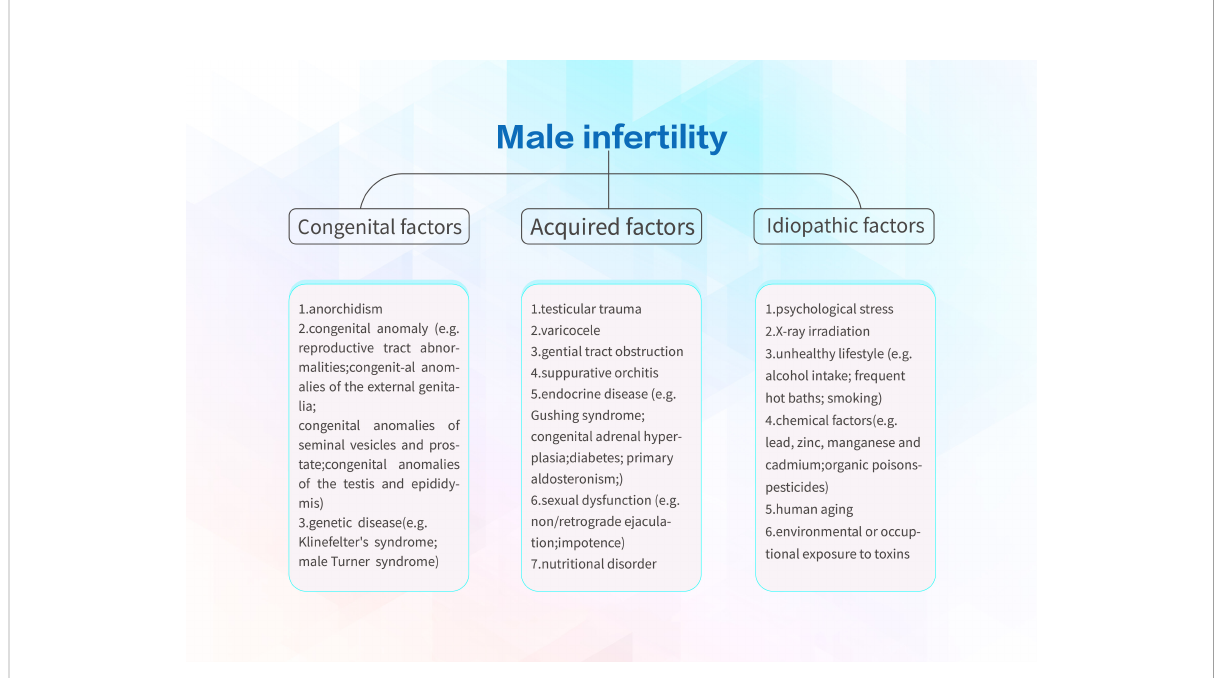
FIGURE 1 The causes and potential risks of male